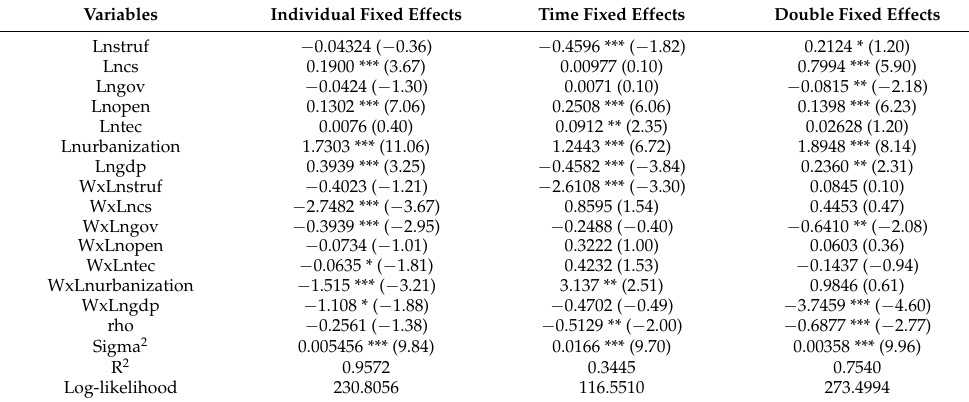
Table 4. Estimation results of the SPDM